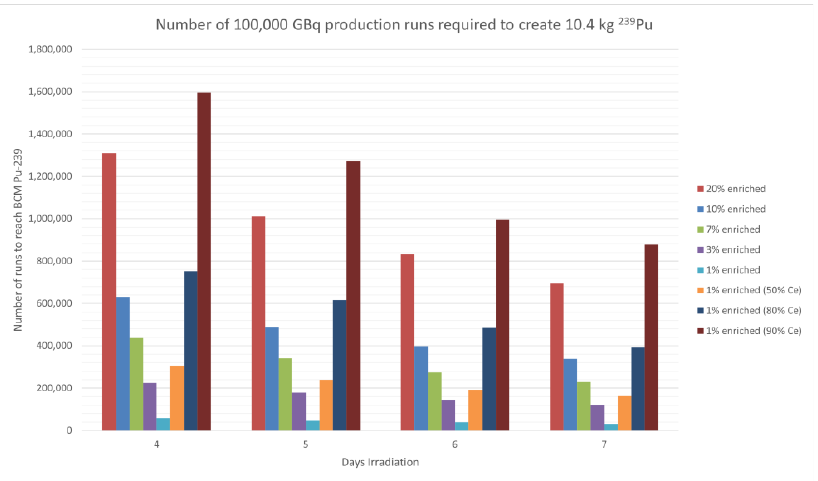
Figure 9. Comparison of number of 100,000 GBq runs to produce 1 BCM of 239 Pu with different enrichment levels in [32] compared with 50% and 90% Ce added to the target.